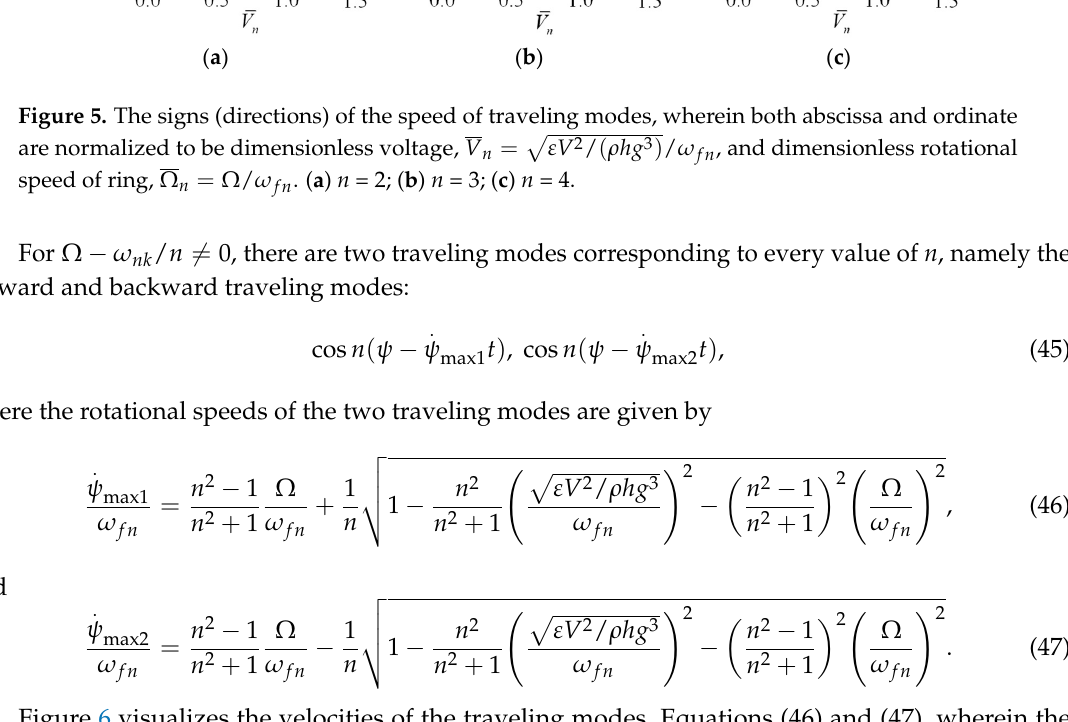
forward traveling modes while the dashed lines illustrate those of the backward traveling